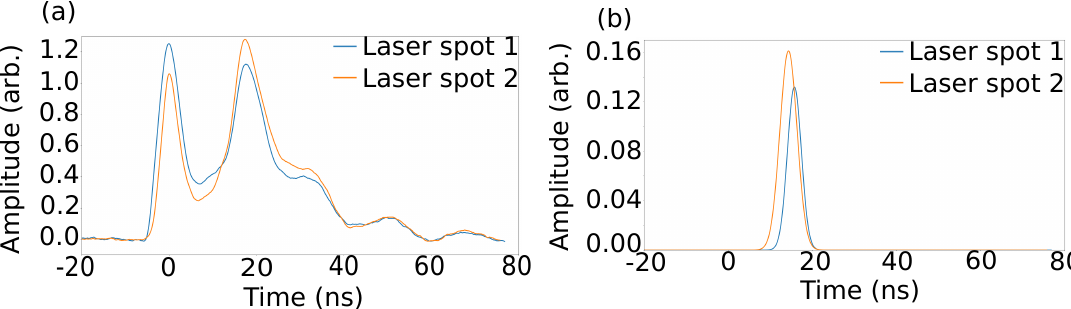
Figure 2. ( a ) Example signals recorded by the system after smoothing, one for each laser spot. ( b ) The Gaussian fits to the same signals after background